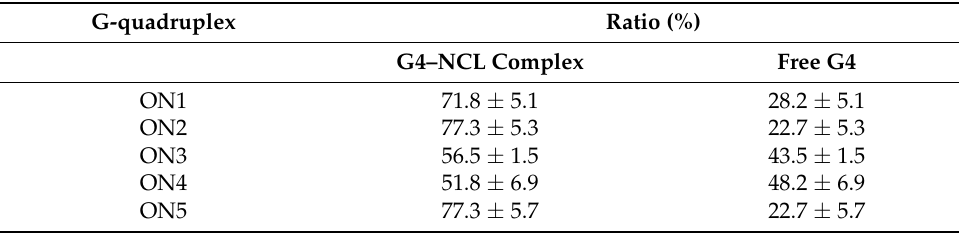
Figure 7. Binding ability of oligonucleotides ON1 to ON5 to interact with nucleolin at a 1:60 ratio. In the EMSA gel, the G4–NCL complexes indicated the ability of each G-quadruplex studied to bind to nucleolin. Reaction mixtures containing only free G-quadruplex. Table 3. Ability of the G-quadruplexes to bind to